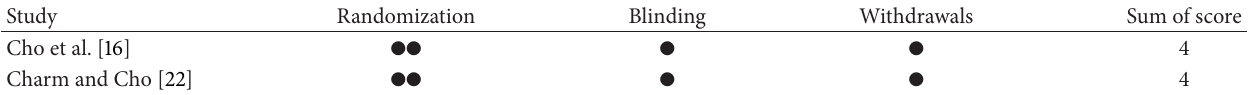
Table 3: Jadad scale for randomized controlled studies.